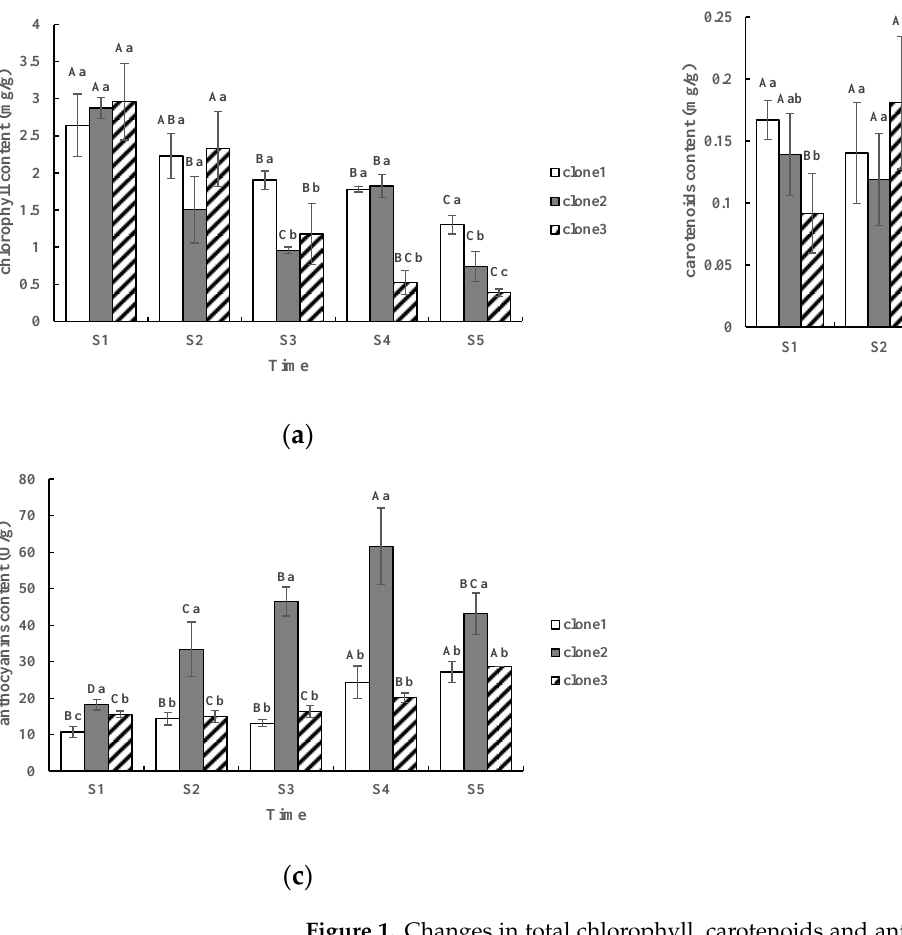
Figure 1. Changes in total chlorophyll, carotenoids and anthocyanin contents during the leaf coloration: ( a ) changes in total chlorophyll content in different clones; ( b ) changes in carotenoids content in different clones; ( c ) changes in anthocyanin content in different clones. Different lowercase letters within each graph indicate significant differences ( p < 0.05) among different clones, while different capital letters within each graph indicate significant differences among different time periods ( p < 0.05). There were three biological replicates in each clone at each stage.